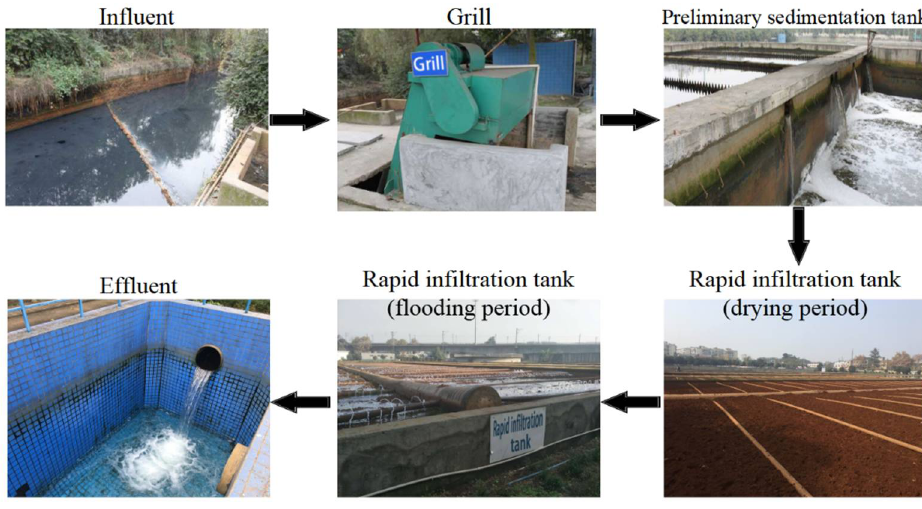
Figure 1. Practical engineering of the Phoniex River CRI system operated successfully for 12 years in Chengdu, China.